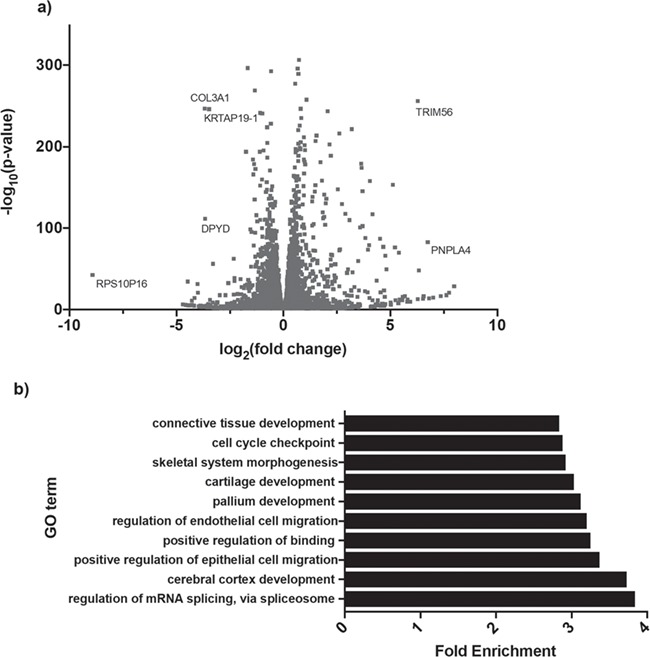
Transcriptome-wide differential gene expression in EFTUD2-knockdown cells. (a) Volcano plot showing all 10 442 significantly DEGs (Padj < 0.05) in EFTUD2-knockdown cells obtained by whole transcriptome RNA-Seq and analysed using DESeq2. A total of 5323 DEGs were significantly downregulated (log2foldchange > 0) in 3.C9 cells while 5119 DEGs were significantly upregulated (log2foldchange < 0) in 3.C9 cells. RNA-Seq was performed on six replicate samples for each of WT and 3.C9 cells. (b) Top 10 enriched Gene Ontology (GO) terms for biological processes associated with the top 1000 most significantly (lowest p-value) differentially expressed genes in EFTUD2-knockdown cells, obtained using the PANTHER Overrepresentation Test (release 2019-03-08, annotation data set GO Biological Processes Complete, Fisher’s Exact test with Bonferroni correction).